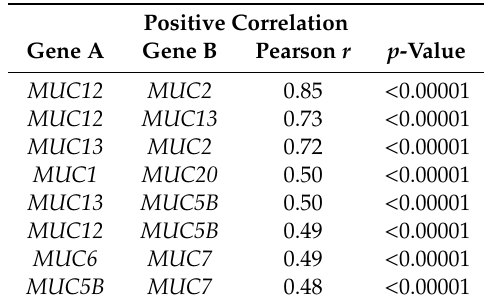
Figure 4. Correlation analysis of relative mucin mRNA levels in pancreatic adenocarcinoma (PAAD) cohortoftheTCGA.( A )CorrelationPearson r valueswerecalculatedforeachmucinmRNAcombination from PAAD cohort. ( B ) Principal component analysis (PCA) of mucin mRNA relative expression in PAAD cohort. Positively correlated variables are grouped together, whereas negatively correlated variables are on opposite sides. A 90 ◦ angle, formed by two arrows, illustrates independency of variables. Cos 2 (square cosine, squared coordinates) indicates the quality of representation of the variables on factor map. Table 1. Correlation of Mucin gene expression in PAAD-TCGA ( p <